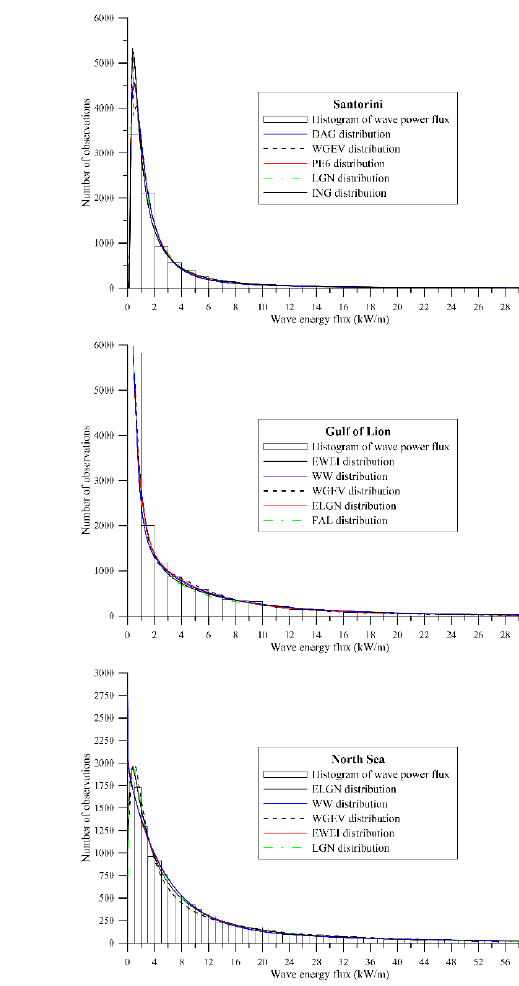
Table 6. Parameters of the best-fit vM mixtures (𝜅,𝜇,𝜔) for the examined locations. Locations